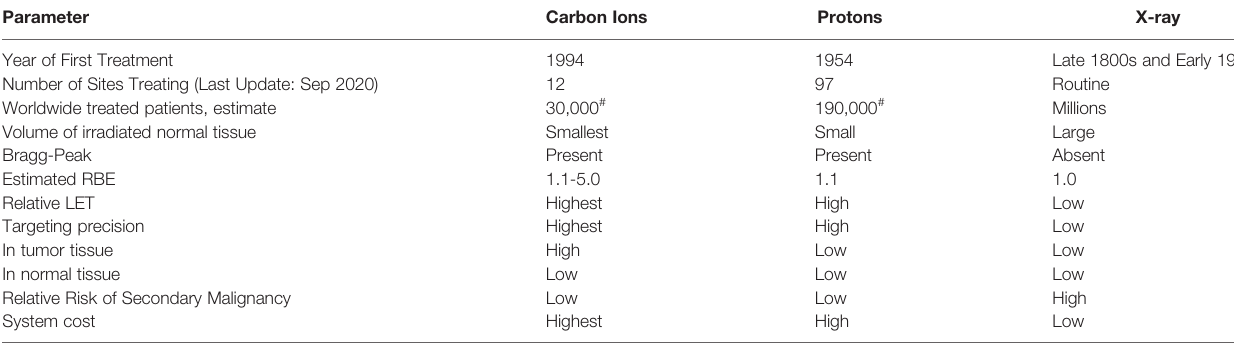
TABLE 2 | Comparison between X-ray, proton, and carbon-based radiotherapy.